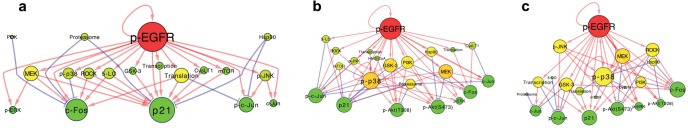
EGF-induced migration signaling network in three cancer cell lines.EGF-induced migration signaling network in (a) A431 cells, (b) EC109 cells, and (c) TT cells. The threshold was set at ±50% from positive control. The edge color is decided based on the sign of edges; red indicates positive signaling, and blue indicates negative signaling. The size of the node indicates the number of connecting edges. The color of the node indicates the number of output pathways: a gradient color scale from green to red, interpolated over yellow.